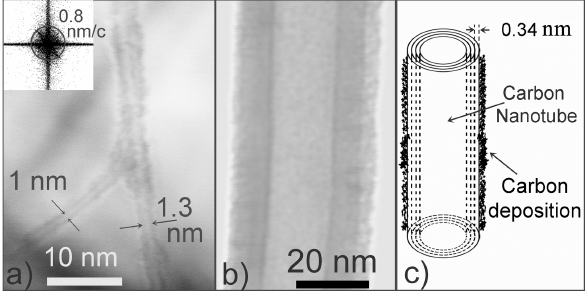
(cid:24) 4 nm thick on the right side, (cid:24) 1–2 nm thick on the left side. Figure 4. ( a ) and ( b ) S(T)EM images of CNTs at the highest-temperature Region (C, (cid:24) 900 ◦ C); inset: FFT power spectrum of ( a ), indicating that the resolution of the image is (cid:24) 0.8 nm; and ( c ) Illustration of a CNT with carbon contamination deposited on the sidewall.